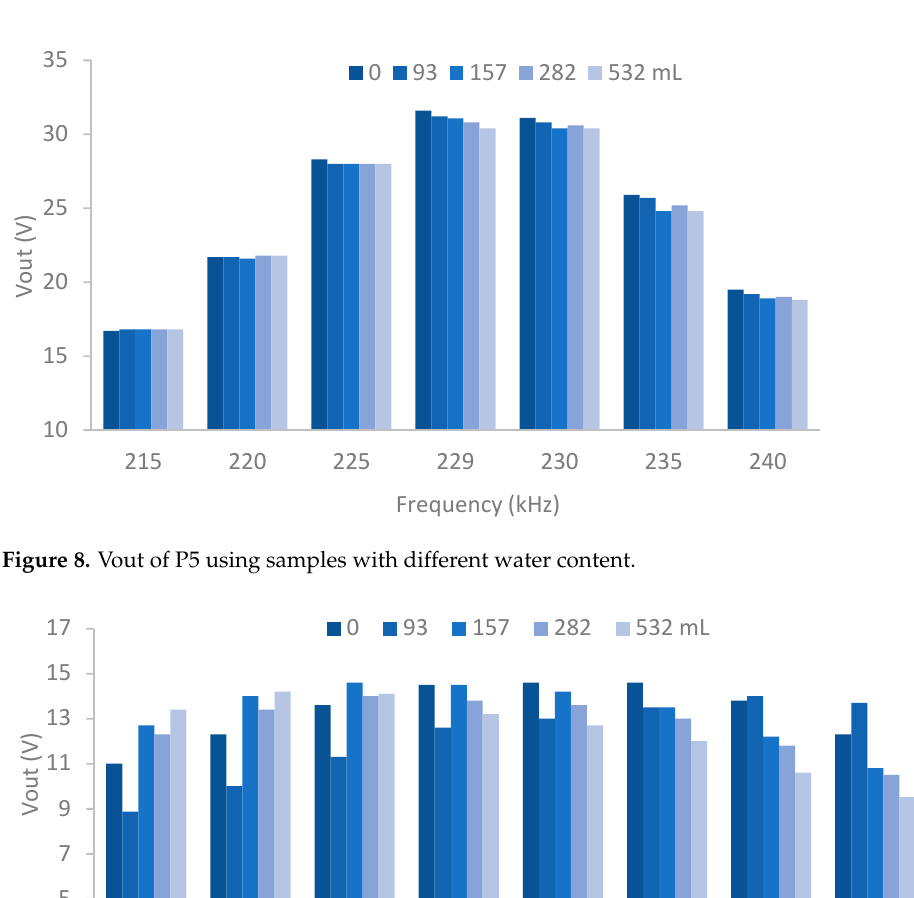
Figure 9. Vout of P8 using samples with different water content.